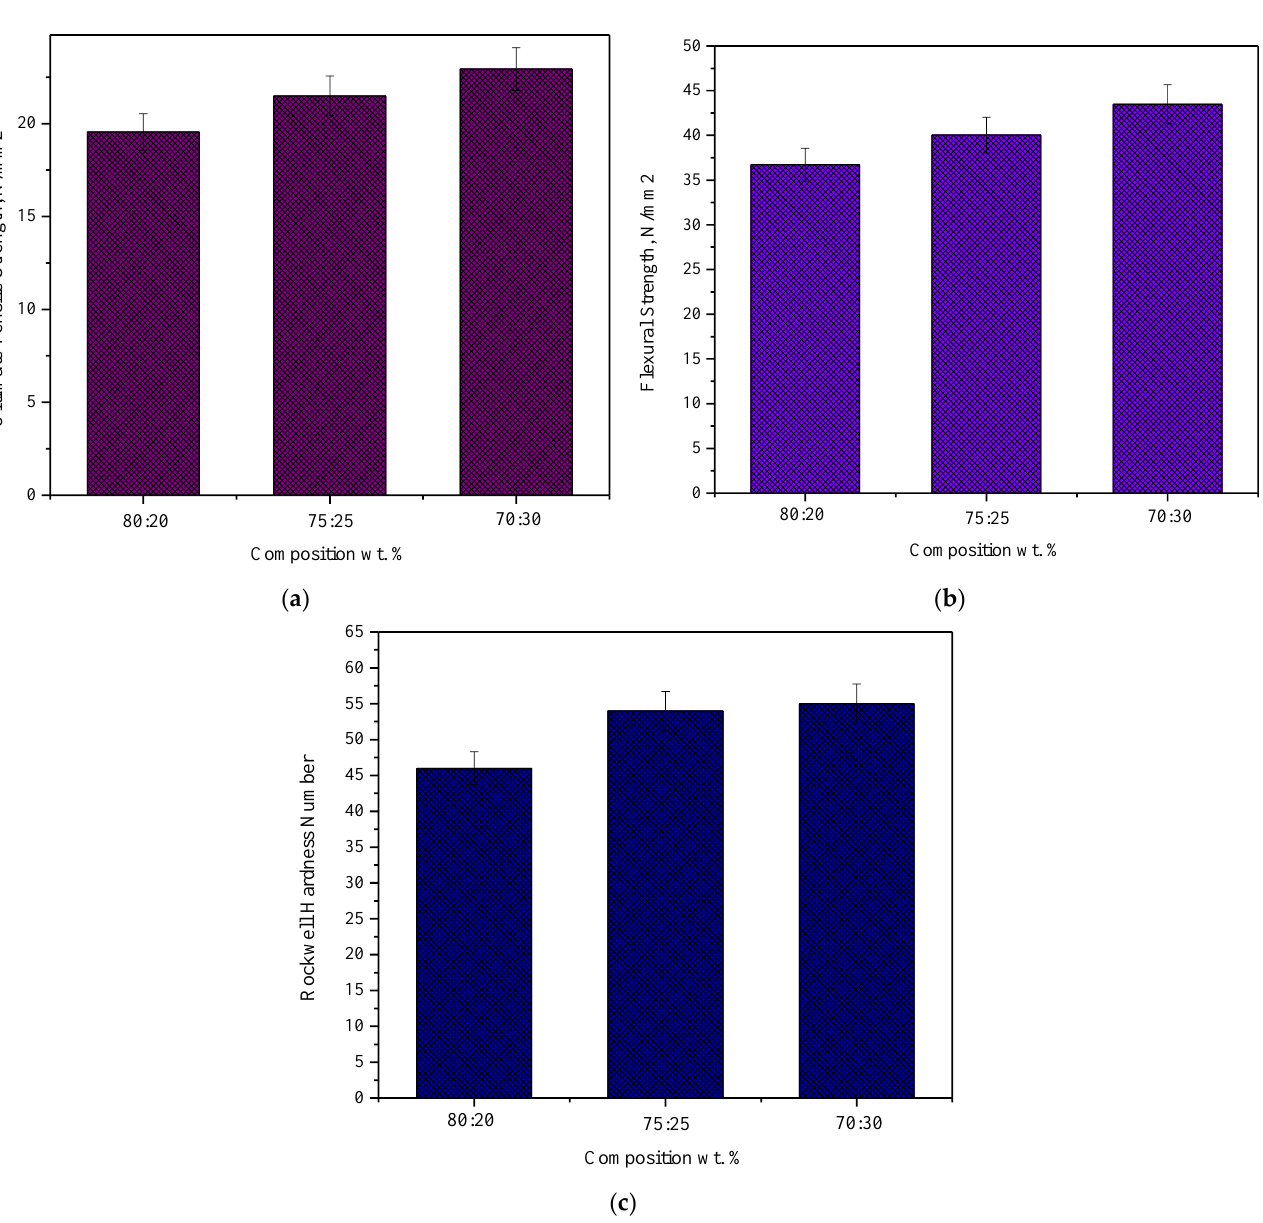
Figure 7. Effect of filler loading on ( a ) tensile strength, ( b ) flexural strength, and ( c ) hardness of sheep horn particle-reinforced composites.